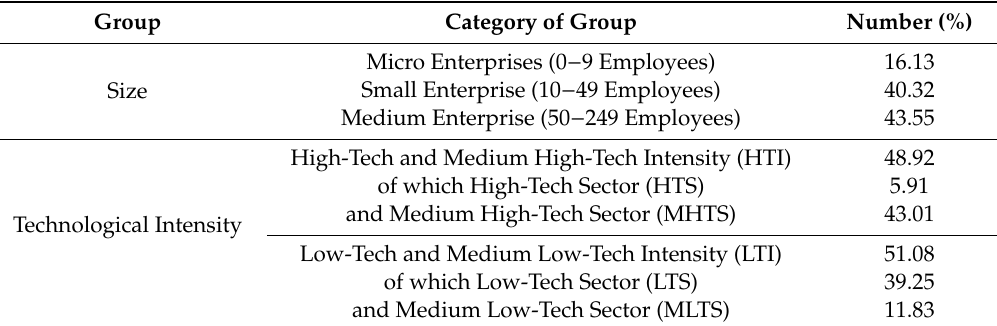
Table 1. Characteristics of research sample for cluster